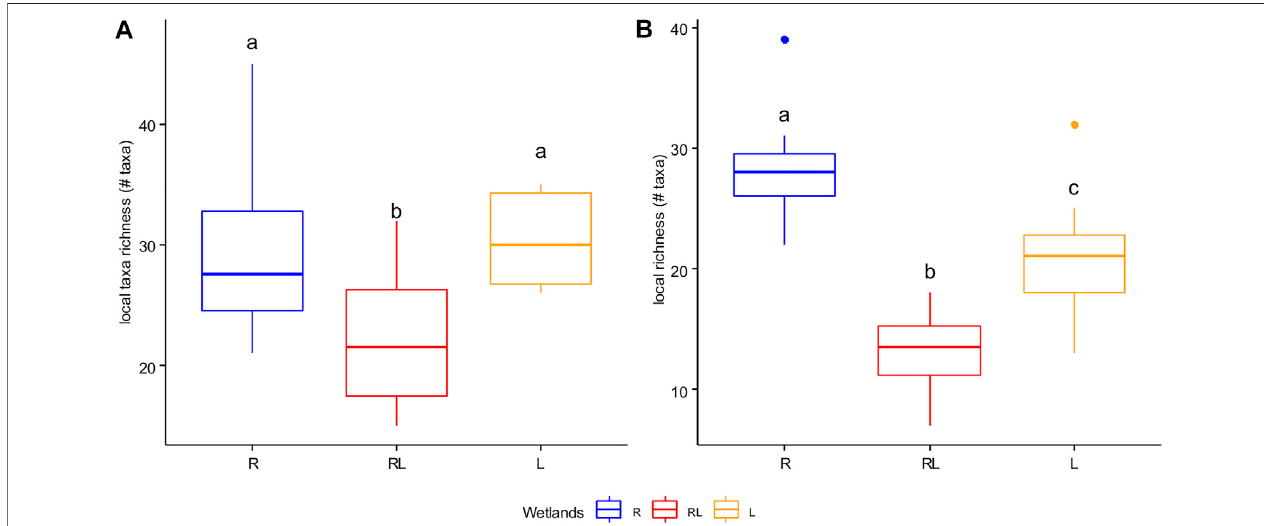
FIGURE 5 | Boxplot with the median (solid line) for local taxonomic richness (number of taxa) of phytoplankton (A) and zooplankton (B) in R = riverine papyrus swamps, RL = river mouth wetlands, and in L = lacustrine wetlands. Data were combined for the dry and the wet season. Boxes that have no letter in common signi fi cantly differ from each other.